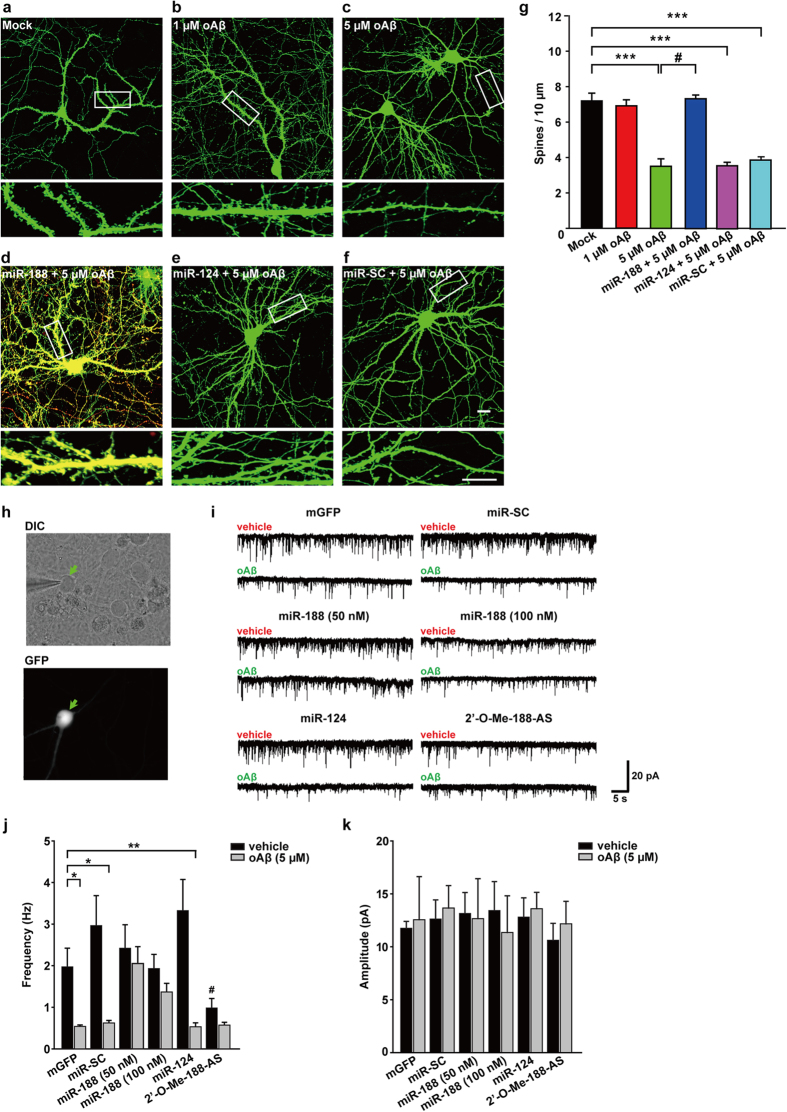
miR-188-5p restored the reduction in dendritic spine density and basal synaptic transmission induced by oligomeric Aβ1-42.(a–f) Representative confocal images of dendritic spines in rat primary hippocampal neurons at DIV 18–20 after treating with oligomeric Aβ1-42 (oAβ) for 24 h either alone or plus transfection with miR-188-5p (IRES-DsRed2), miR-124 or miR-SC oligonucleotides and the IRES-mGFP vector at DIV 10–12. The dendritic segment, outlined with a white box (upper), is magnified to delineate spine morphology (bottom). The scale bars indicate 20 μm (low-scaled panel) and 5 μm (magnified panel). (g) Treatment with oAβ (5 μM) for 24 h at DIV 17 induced a significant reduction in dendritic spine density (n = 9 neurons, vs. vehicle-treated group, n = 10 neurons, one-way ANOVA). However, transfection with the miR-188-5p oligonucleotide rescued the reduction in dendritic spine density induced by treatment with oAβ (n = 9 neurons, one-way ANOVA). Data are represented as the mean ± SEM. ***p < 0.001 compared to Mock; #p < 0.01 compared to 5 μM oAb. (h) Representative images of the single whole-cell recording model used to measure transfected neurons (green arrow) at DIV 18–20. (i) Sample traces of mEPSCs recorded in rat primary hippocampal neurons treated with vehicle or 5 μM oAβ either alone or plus transfection with miR-SC, miR-124, miR-188-5p or 2′-O-Me-188-5p-AS oligonucleotides and the IRES-mGFP vector at DIV 10–12. Five minutes of representative mEPSC recordings were used to generate the cumulative distribution plot. (j) Bar graphs show the mean values of mEPSC frequencies of vehicle (black bar) and 5 μM oAβ-treated (gray bar) rat primary hippocampal neurons. Co-transfection of miR-188-5p (50 or 100 nM) with mGFP completely reversed the reduction of mEPSC frequency induced by 5 μM oAβ (n = 7 vs. vehicle, n = 8, p > 0.05). *p < 0.05, **p < 0.01 compared to mGFP-transfected control. (k) The mEPSC amplitudes of rat primary hippocampal neurons treated with each vehicle (black bar) were not altered compared to the 5 μM oAβ-treated neurons (gray bar). The statistical comparisons of synaptic currents were made using the Kolmogorov-Smirnov test. Statistical analysis was performed by an independent T test or nonparametric Mann-Whitney test; data represents the mean ± SEM. oAβ = oligomeric Aβ1-42.